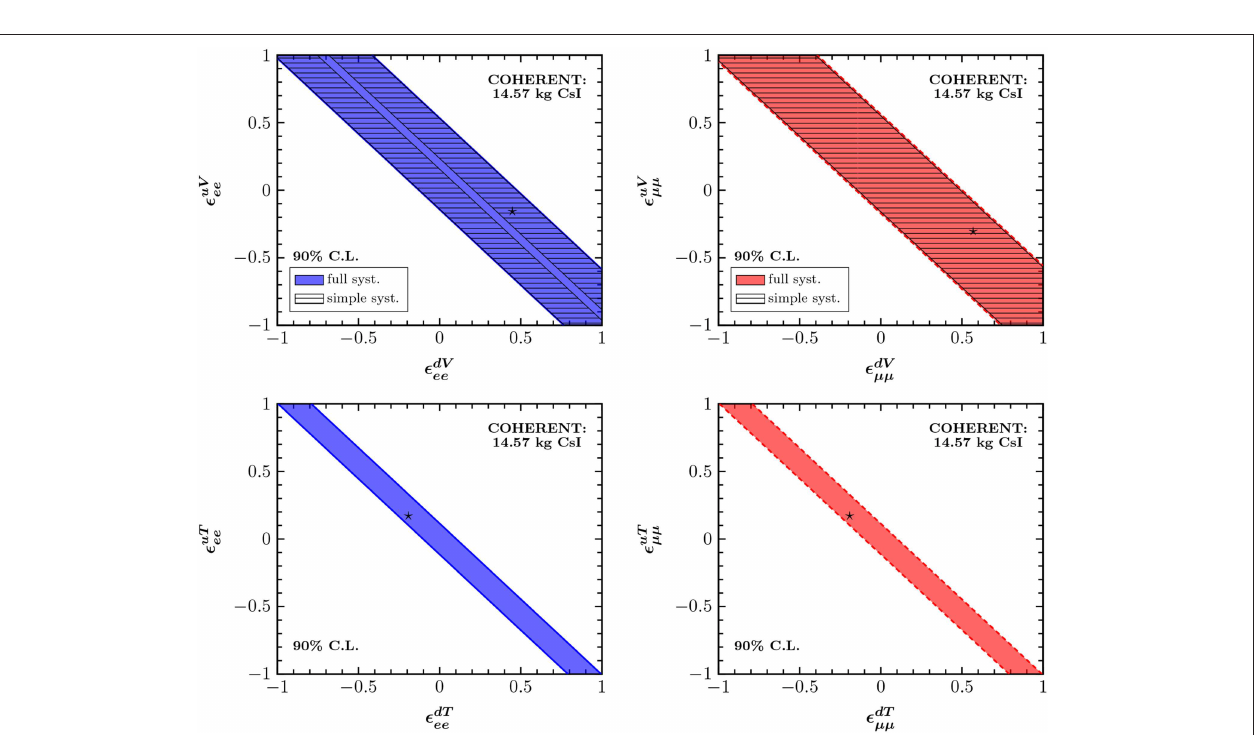
FIGURE 10 | Sensitivity of COHERENT to vector (Left) and tensor (Right) NSI parameters. Thick (thin) curves correspond to the ν e ( ν µ from Papoulias and Kosmas [21] under the terms of the Creative Commons Attribution 4.0 International license.